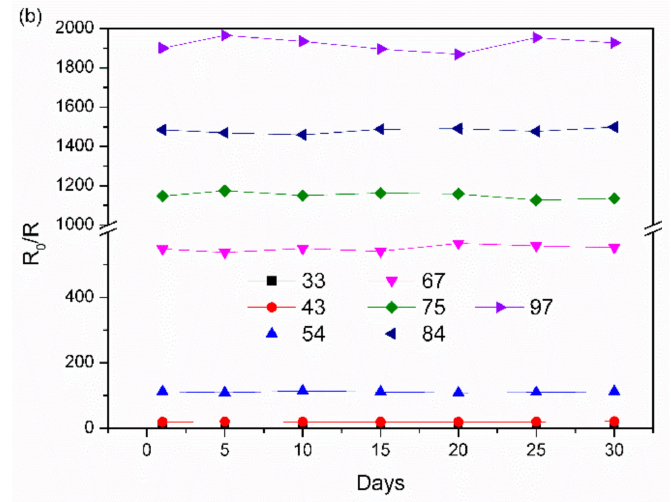
Figure 6. ( a ) Dynamic response curves of 6% TiNP/CNC-based humidity sensors to various relative humidity levels and ( b ) variations in response of 6% TiNP/CNC-based humidity sensors following exposure to 33–97% RH.